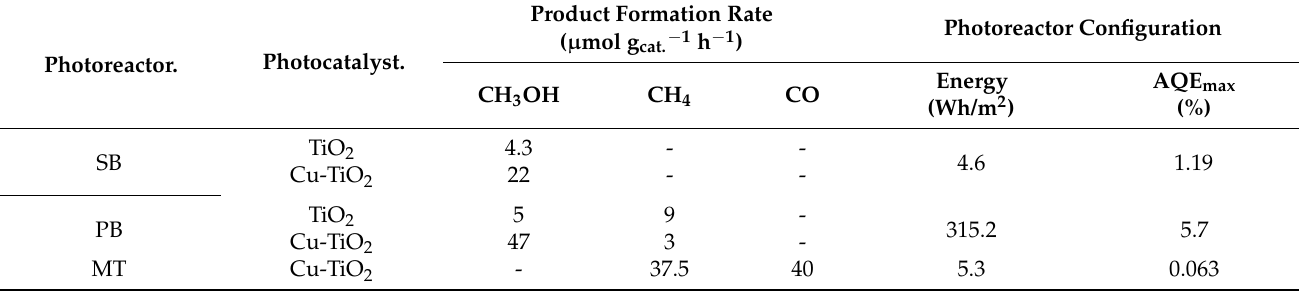
Table 3. Results of CO 2 photoreduction reaction under UVA 285-W/m 2 irradiation [202].